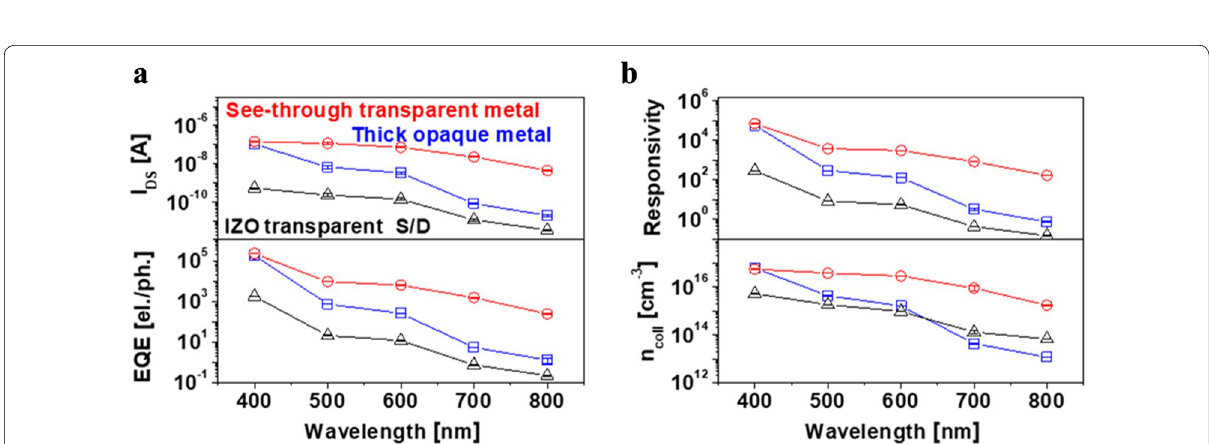
Fig. 4 a I Photo and external quantum efficiency (EQE), b responsivity and collected carrier density values of multi-layer MoS 2 phototransistors with see-through metal, thick opaque metal and IZO transparent metal electrode under illumination at different